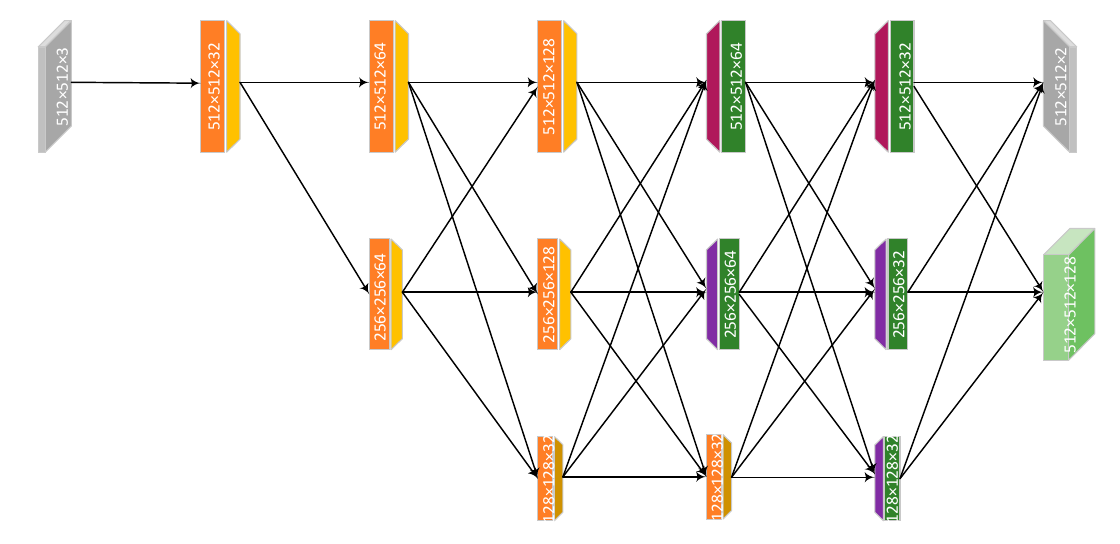
Figure 4. Structure of the feature extraction module.